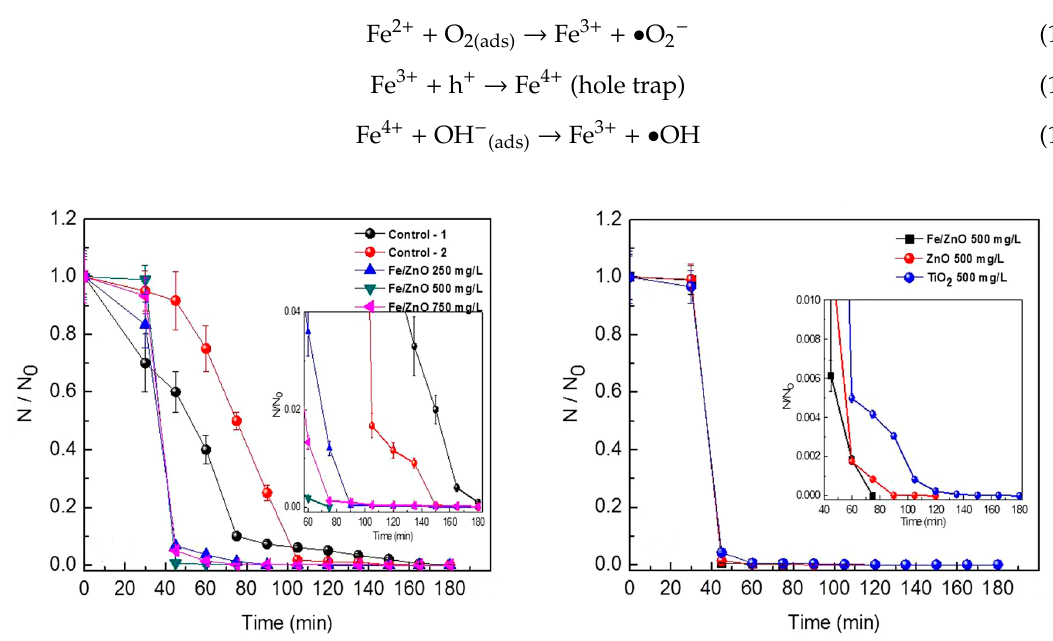
Figure 38. ( a ) Effect of Fe/ZnO NPs concentrations on solar-photocatalytic disinfection (PCD) kinetics of multidrug-resistant (MDR) E. coli . Control-1: bacteria exposed to Fe/ZnO NPs in the dark; Control-2: bacteria without Fe/ZnO NPs under solar irradiation. ( b ) Effect of different catalysts on the solar-PCD kinetics of MDR E. coli at a catalyst concentration of 500 mg/L. Initial MDR E. coli concentration = 1.2 × 10 7 CFU/mL, temperature = 35 ± 2 °C, pH = 6.5. Error bars indicate standard deviation of replicates ( n = 3). Reproduced from [306] under a Creative Commons Attribution 4.0 International